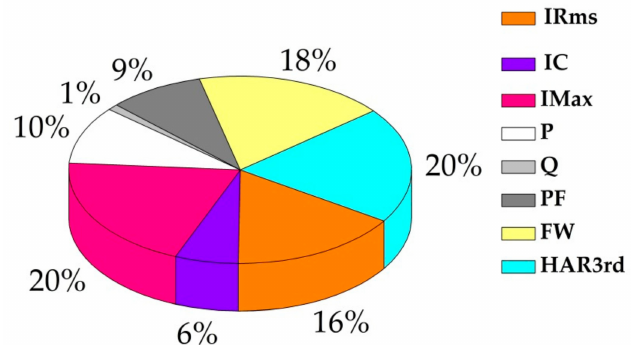
Figure 9. The importance of di ff erent features.